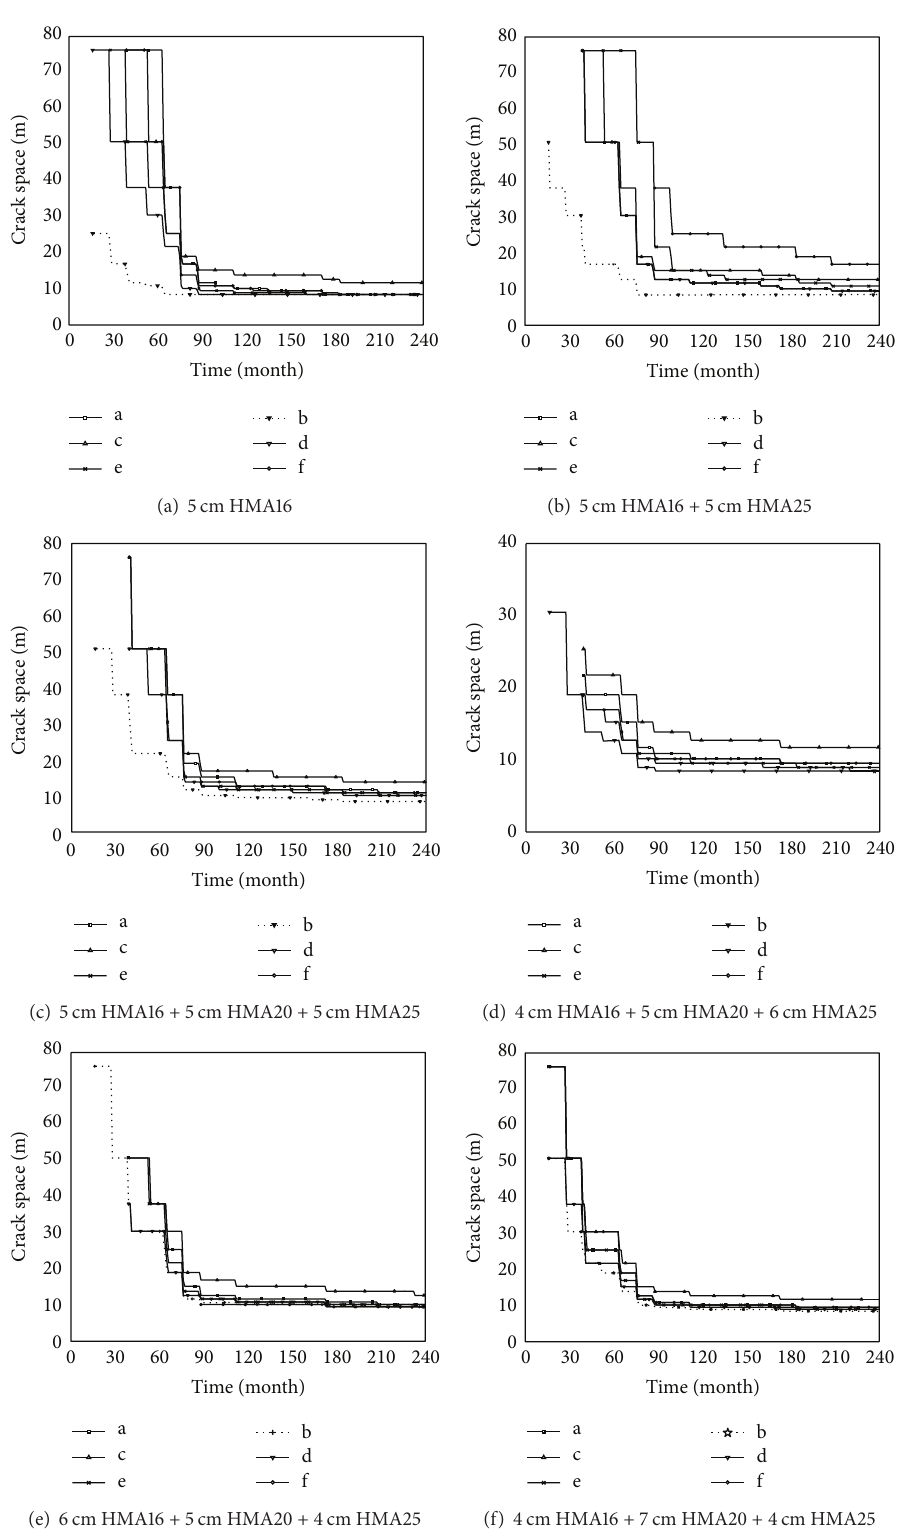
Figure 8: Thermal cracking development of asphalt pavements with different asphalt layers. Note: the terms “a,” “b,” “c,” “d,” “e,” and “f” were defined in Table